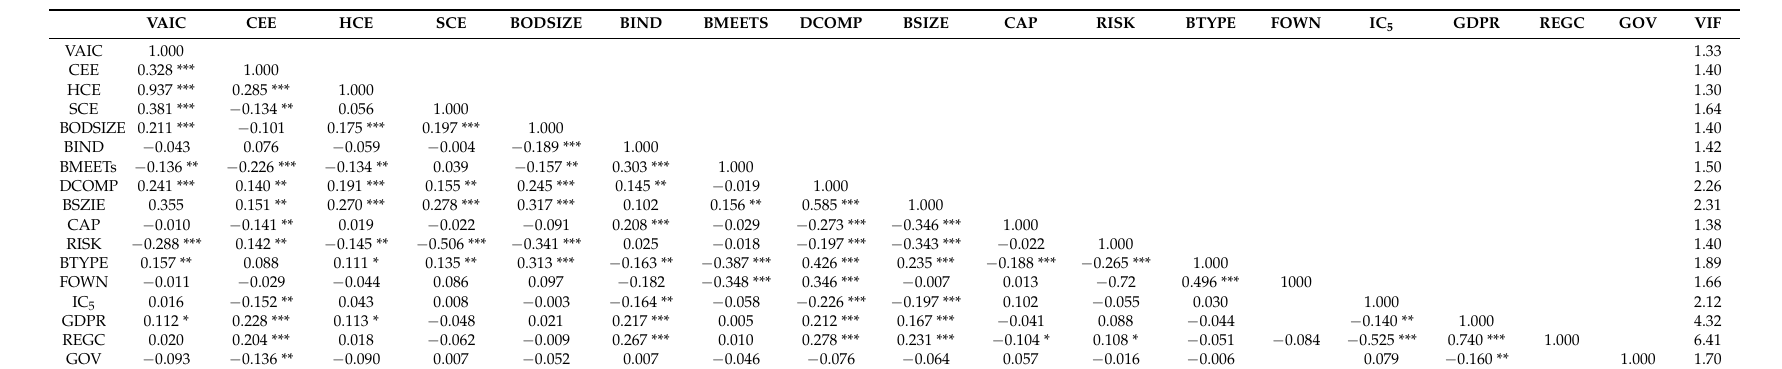
Table 4. Correlation